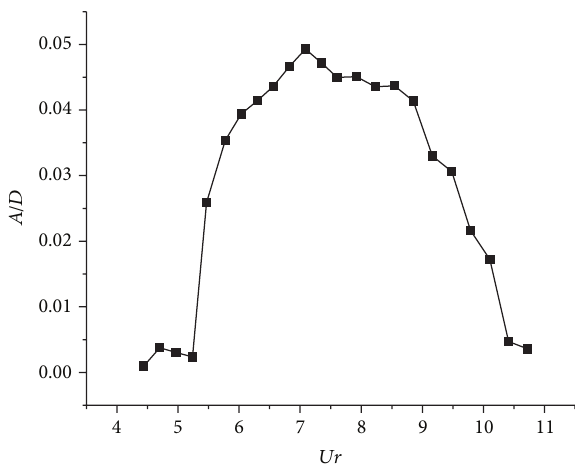
Figure 6: Amplitude of the bare cylinder versus the reduced wind speed.